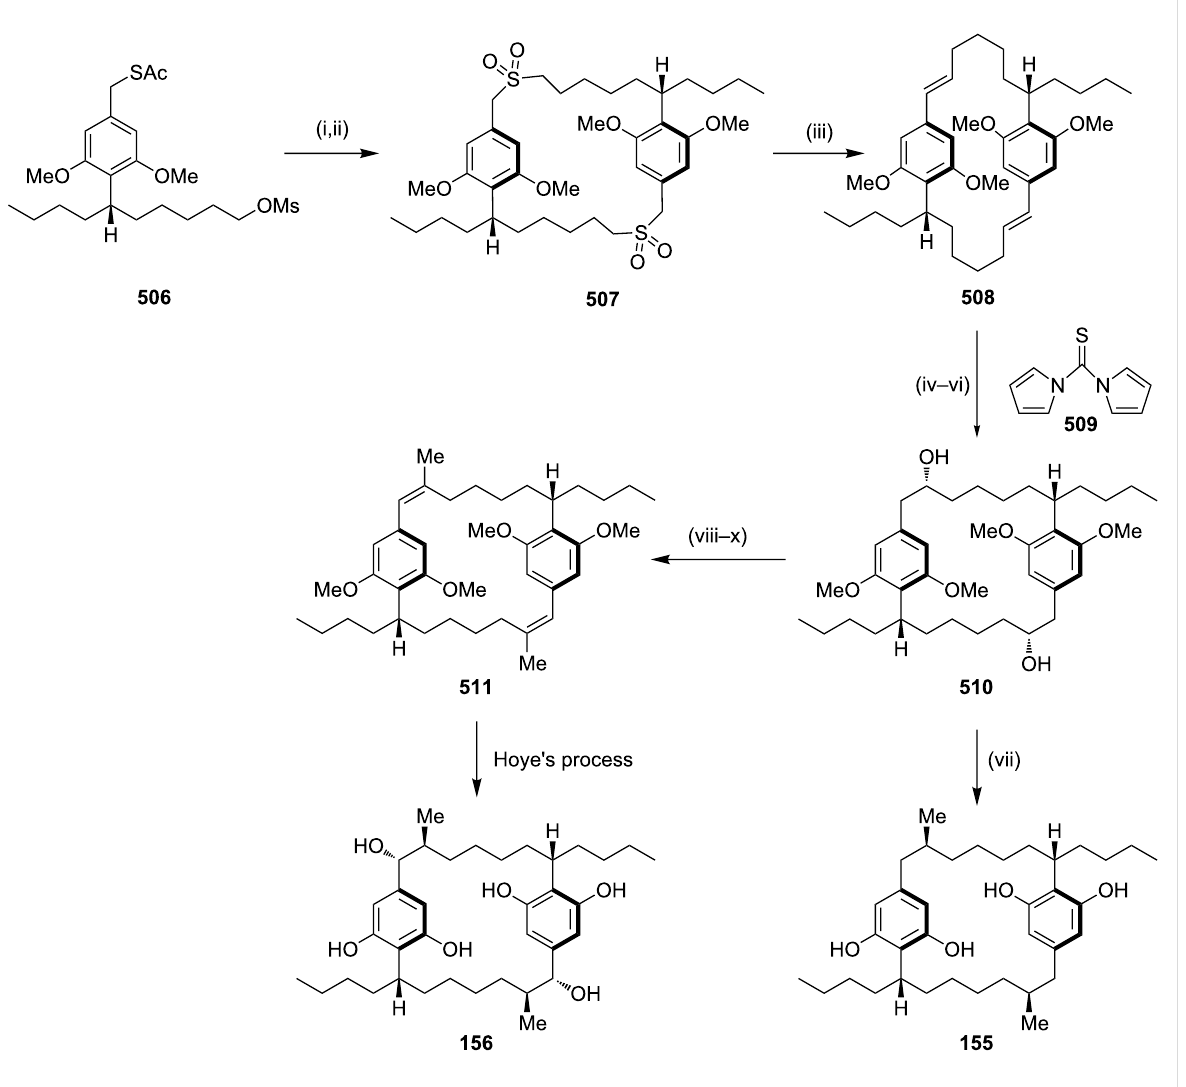
Scheme 94: Synthesis of ( − )-cylindrocyclophanes A ( 156 ) and ( − )-cylindrocyclophanes F ( 155 ). Reagents and conditions: (i) NaOMe, MeOH, 23 °C, 36 h; (ii) (NH 4 ) 6 Mo 7 O 24 ·4H 2 O, H 2 O 2 , EtOH, 23 °C, 12 h, 51% over two steps; (iii) CF 2 Br 2 , KOH/Al 2 O 3 , CH 2 Cl 2 / t -BuOH 1:1, 0–23 °C, 2 h; then [Pd(CH 3 CN) 2 Cl 2 ], 40 °C, 4 h, 70%; (iv) AD-mix- β , MeSO 2 NH 2 , t -BuOH/H 2 O 2:1, 23 °C, 12 h; (v) 509 , PhMe, 125 °C, 5 h; (vi) AIBN, n- Bu 3 SnH, PhMe, 100 °C, 1.5 h, 50% over three steps; (vii) MsCl, Et 3 N, CH 2 Cl 2 , 0 °C, 0.5 h; then AlMe 3 , 0 °C, 10 min; then BBr 3 , 23 °C, 5 h, 71% one pot; (viii) DMP,